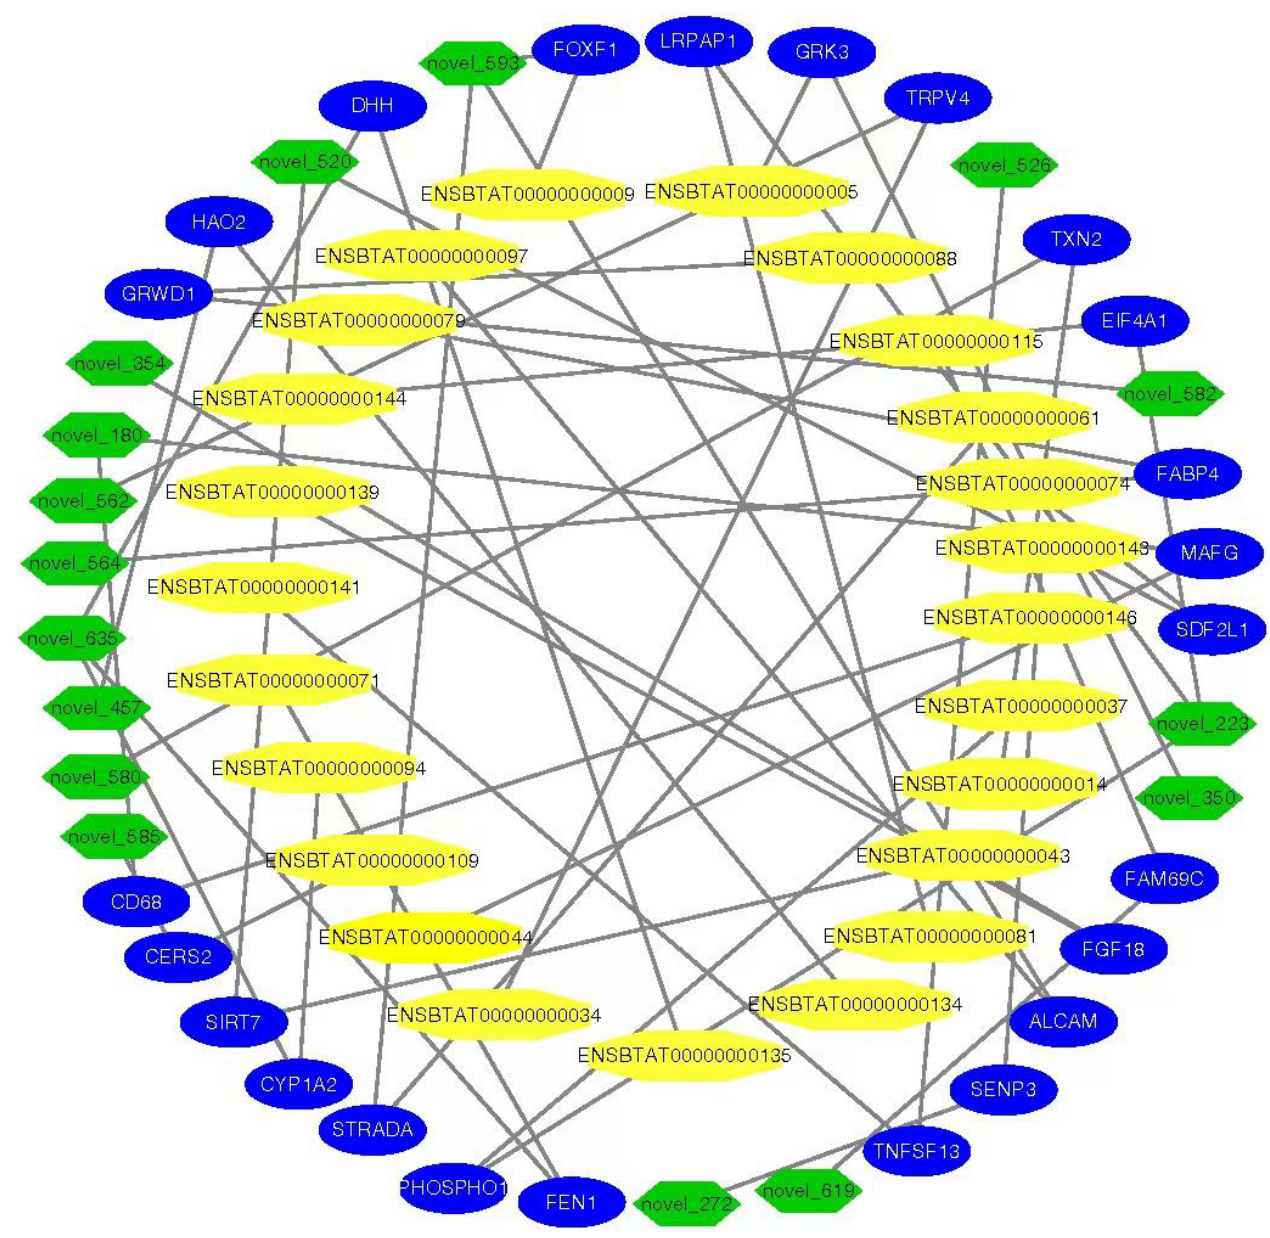
Figure 9. The interactive network of miRNAs, mRNAs and targeted genes were constructed between bull and calf testes. The green-colored nodes exhibit the miRNAs, blue highlights the link target genes, while the yellow color shows the mRNA.